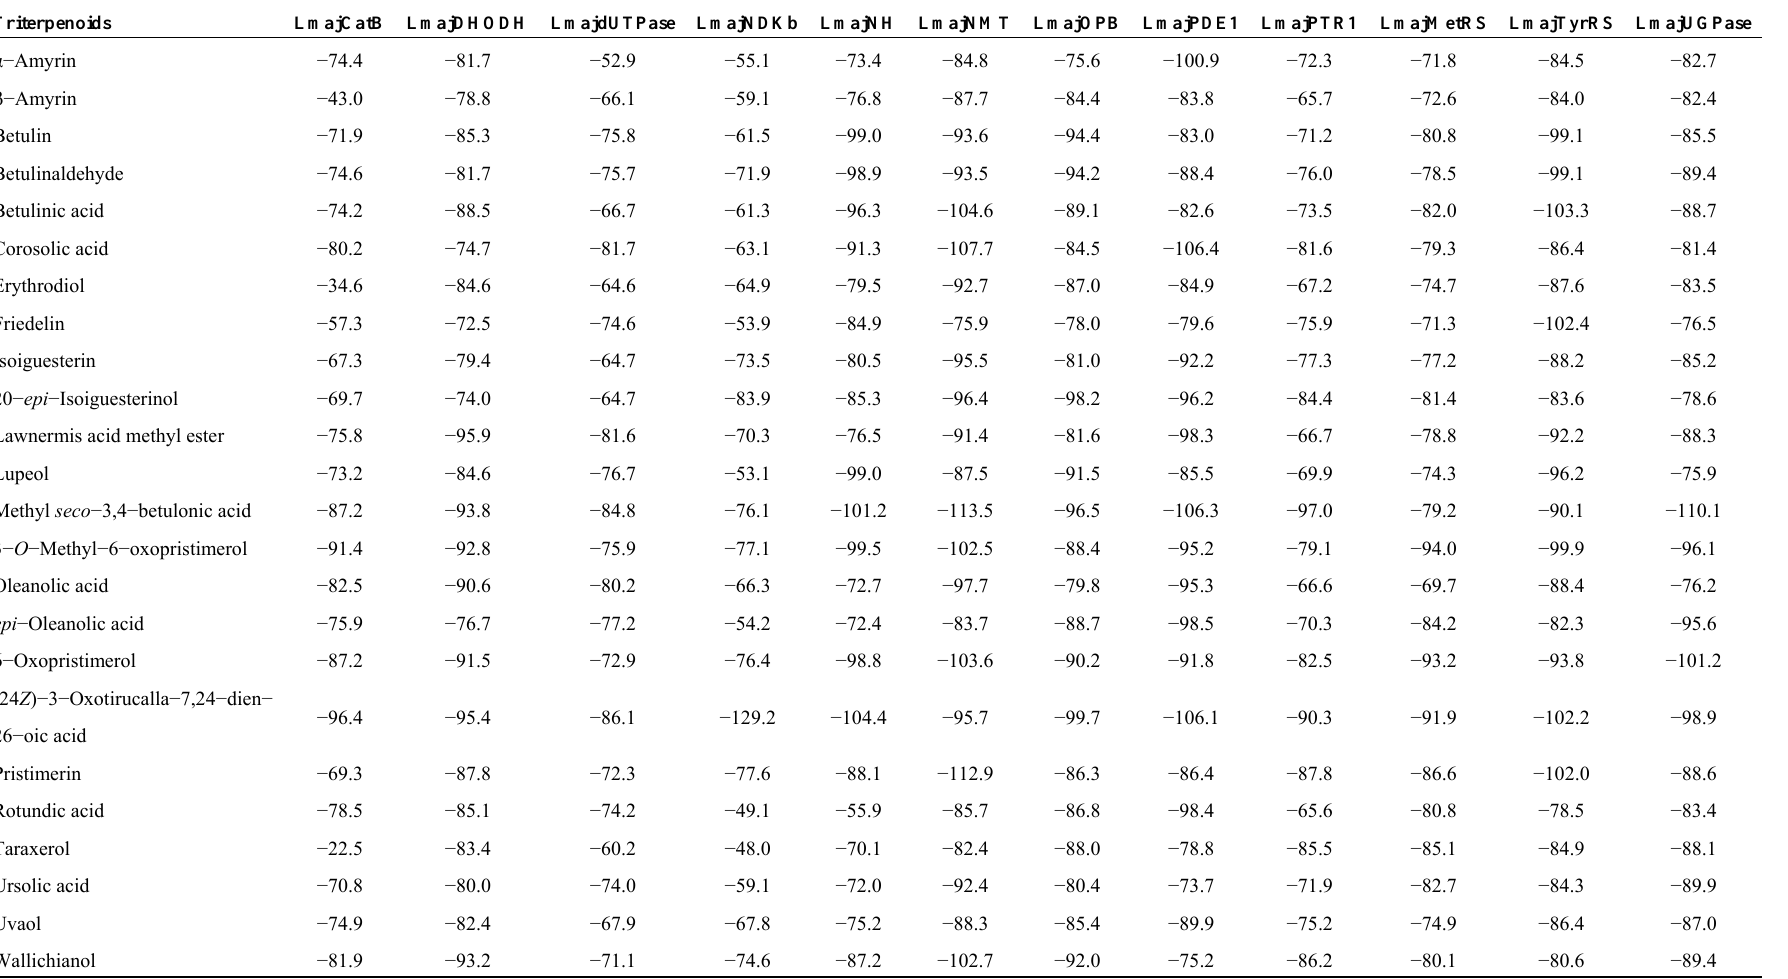
Table 35. MolDock docking energies (kJ/mol) of triterpenoids with Leishmania major protein